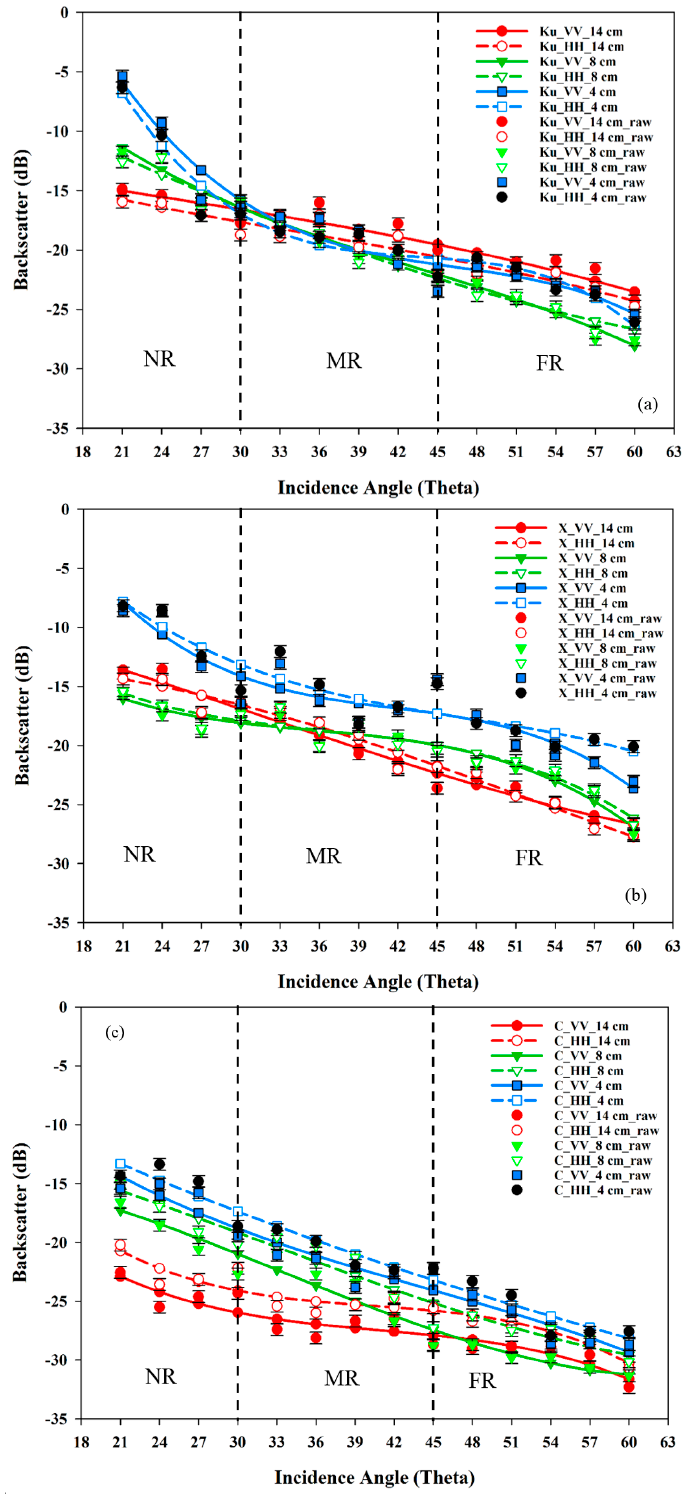
Figure 5. Observed Ku-, X- and C-band backscatter ( σ 0 and σ 0 ), from 14 cm, 8 cm and 4 cm snow covers on FYI acquired on 19 May 2012: ( a ) Ku-band; ( b ) X-band; and ( c ) C-band. Scatterometer backscatter trend lines are cubic fits. Colored points represent measurement points with error bars indicating min-max deviation. Vertical black dotted lines partition near-range (NR), mid-range (MR) and far-range (FR) incidence angles.